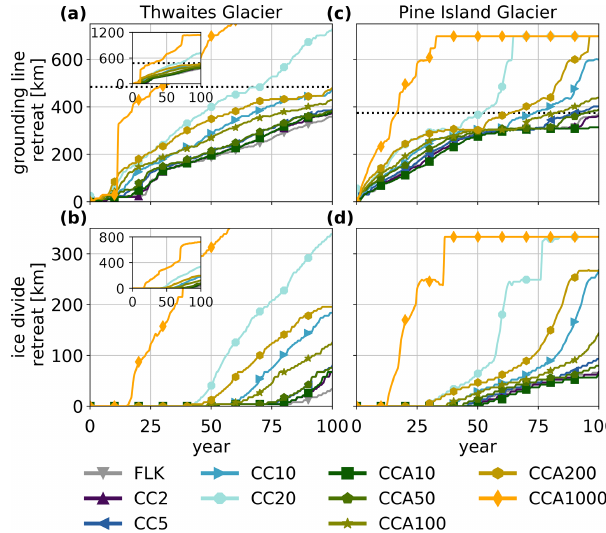
Figure 8. Grounding-line retreat (a, c) and ice-divide retreat (b, d) along the flowlines in Thwaites (a, b) and Pine Island Glaciers (c, d) as a function of simulated time. The dotted line shows the initial ice-divide